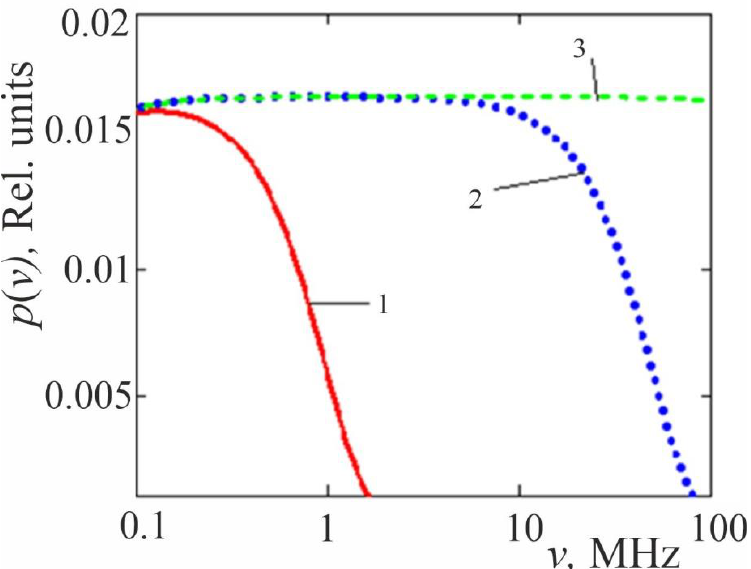
Figure 6. Spectral sensitivity of US excitation in water in beams with radii 500 (1), 10 (2), and 0.5 (3) μm at 80° angle.